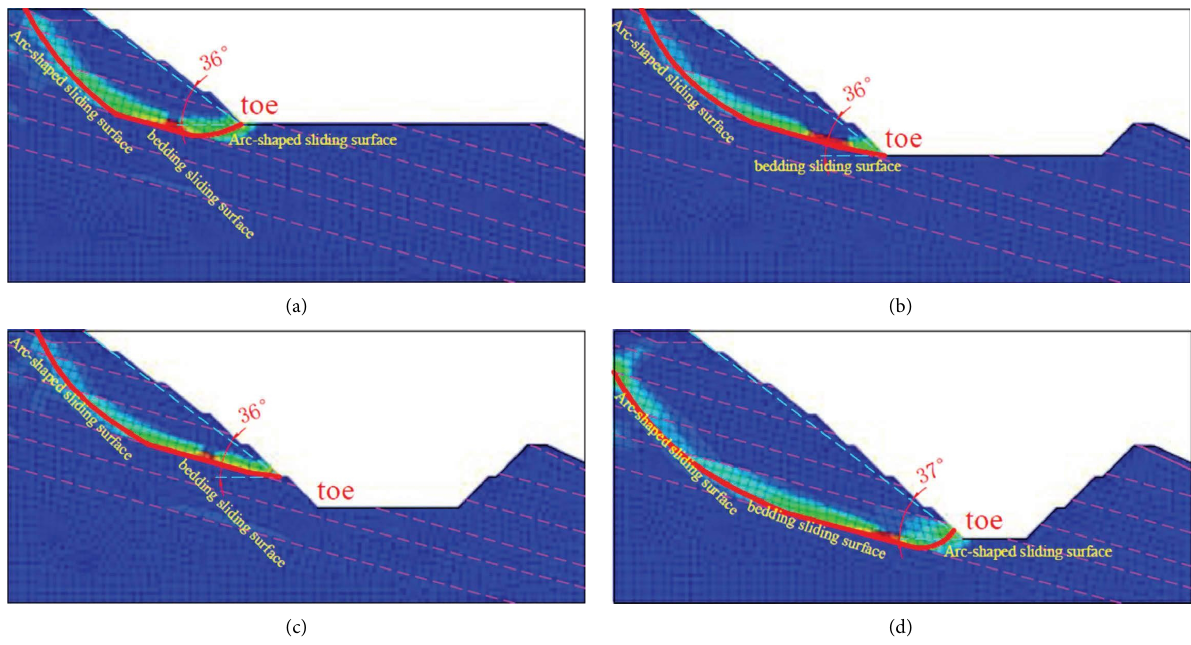
Figure 8: Schematic diagram of sliding surface of slopes at all levels: (a) fourth stage excavation, (b) third stage excavation, (c) second stage excavation, and (d) frst stage